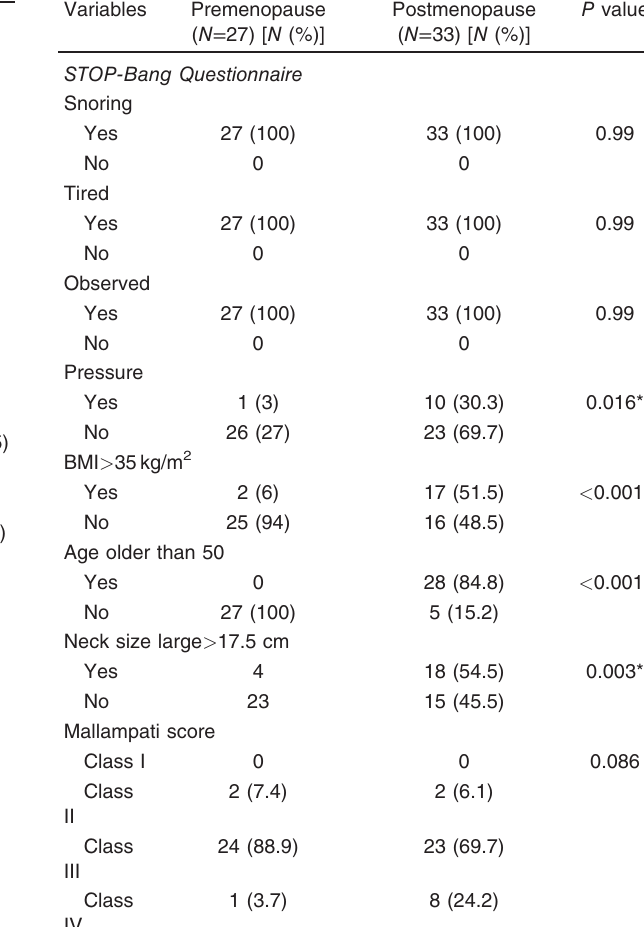
Table 1 Demographic data of the study group Variables